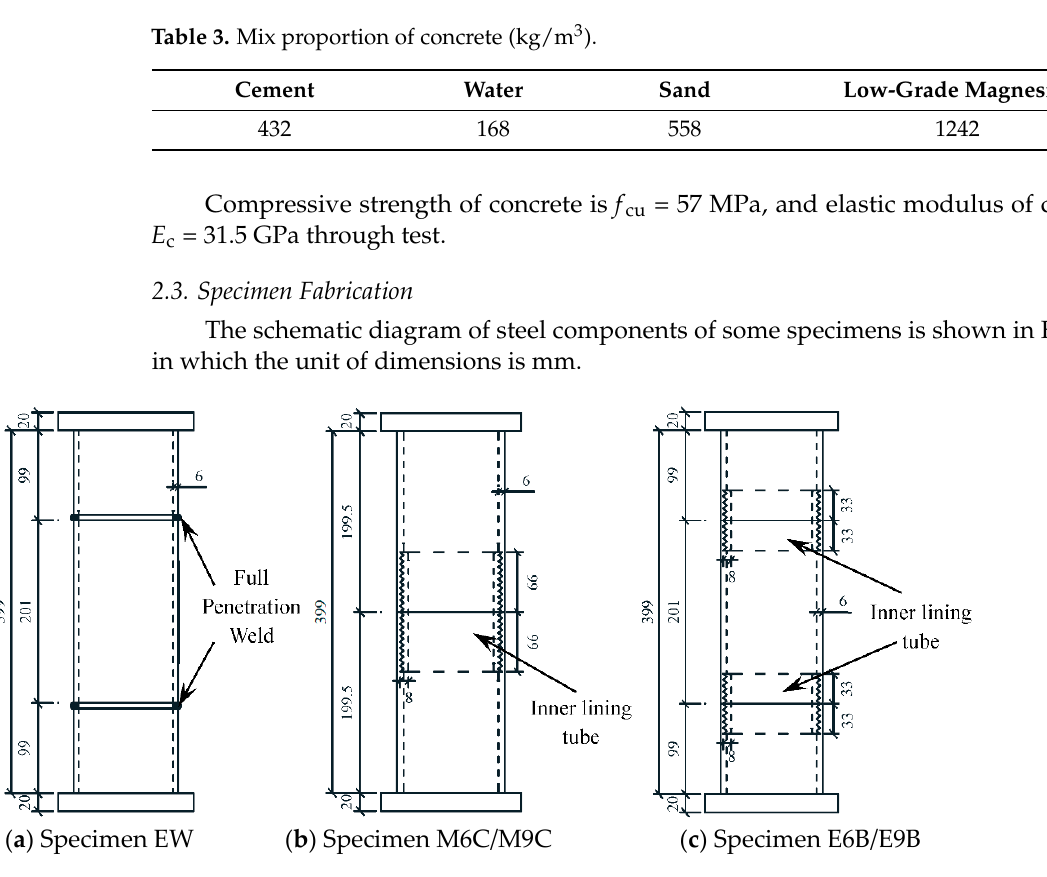
Figure 3. Schematic diagram of steel components of some